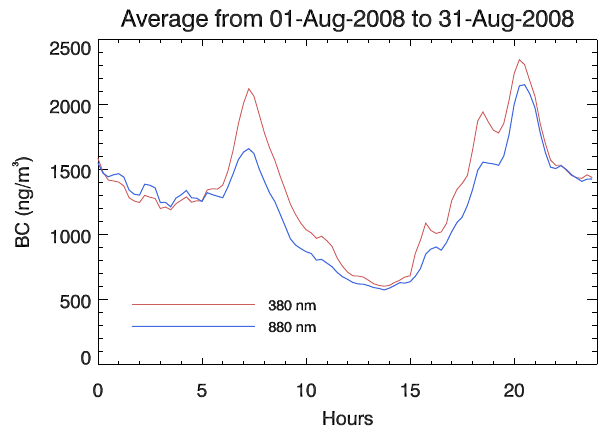
Fig. 4. Diurnal variation of BC concentration obtained using UV channel (370nm) and standard channel (880nm data).